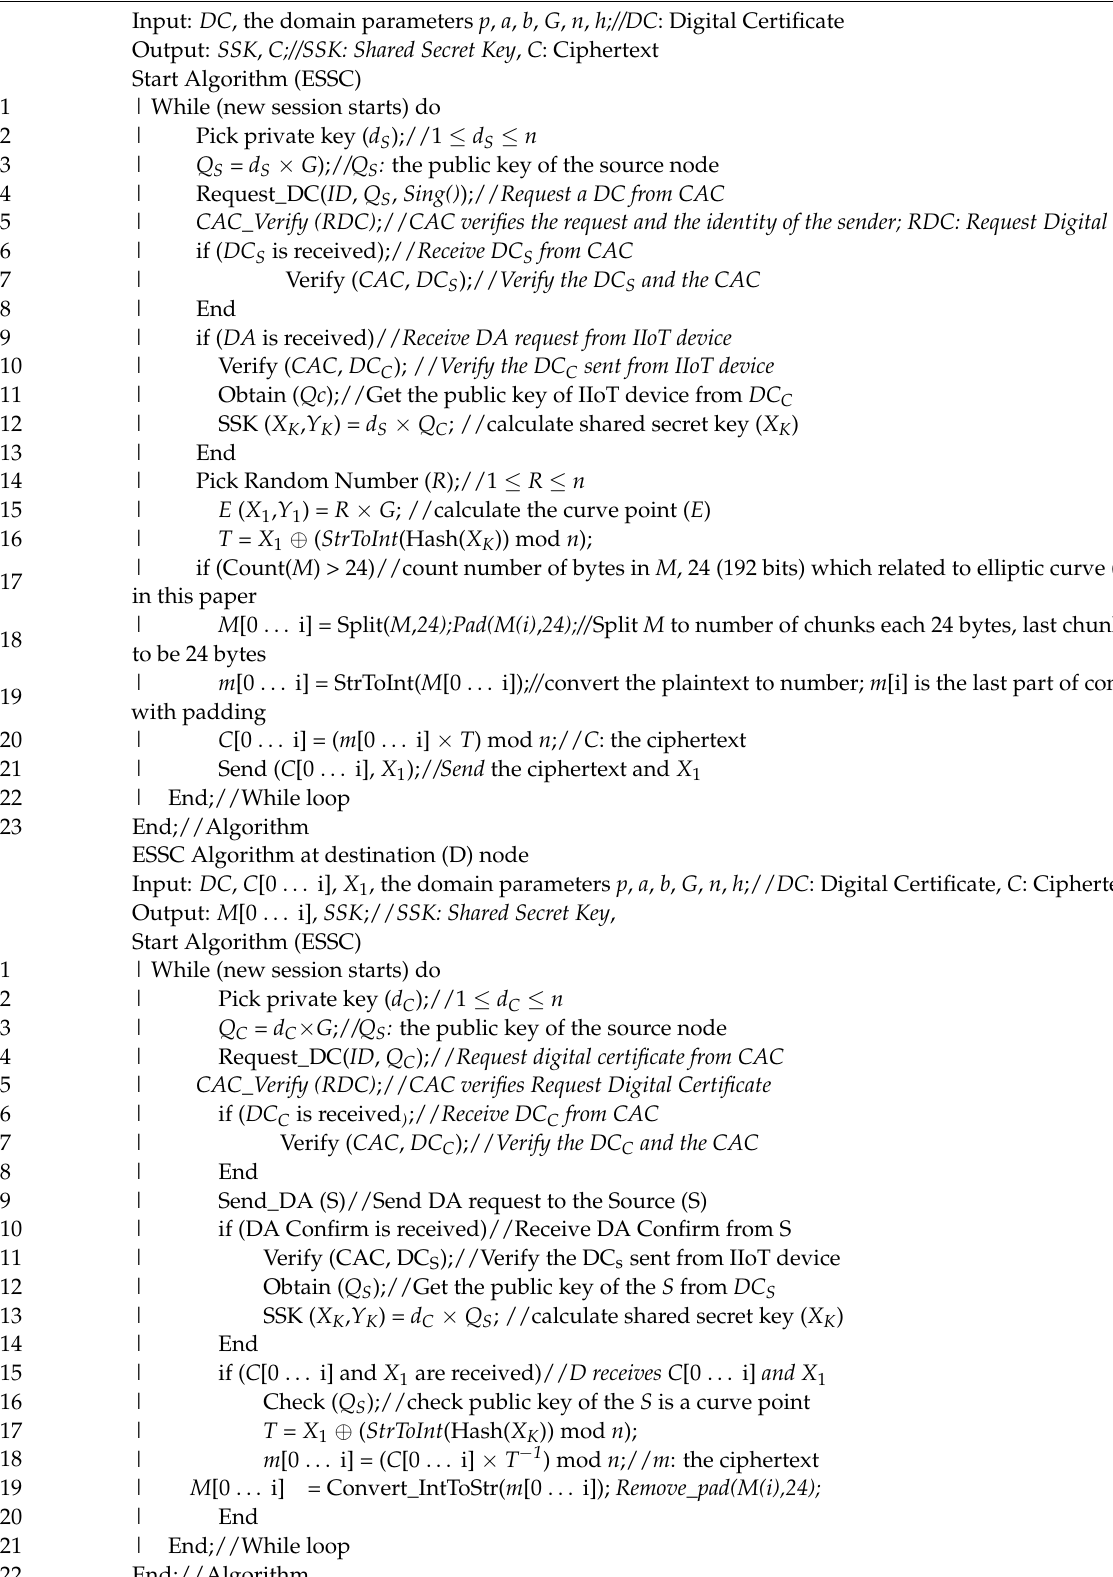
Algorithm 1: ESSC Algorithm at Source (S)